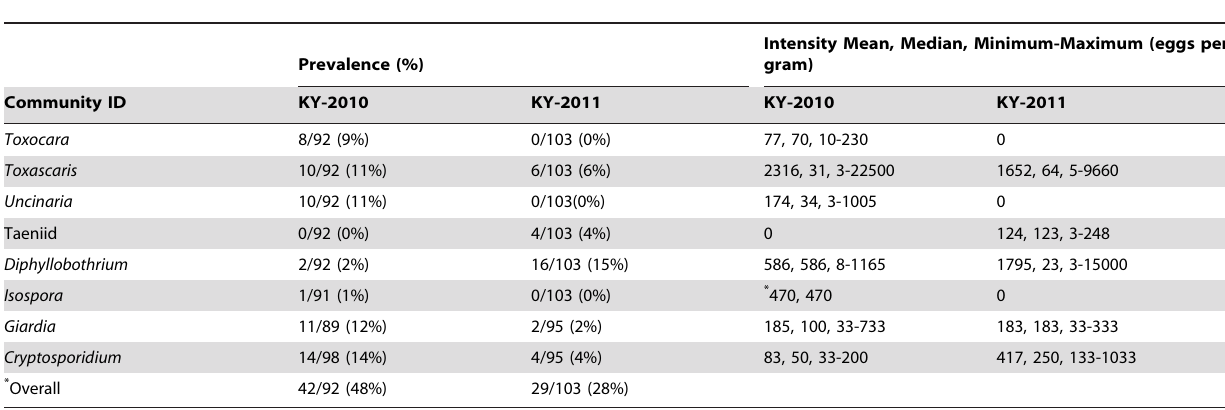
Table 4. Prevalence of canine intestinal parasites identified through quantitative sucrose flotation and immunofluorescent assay.